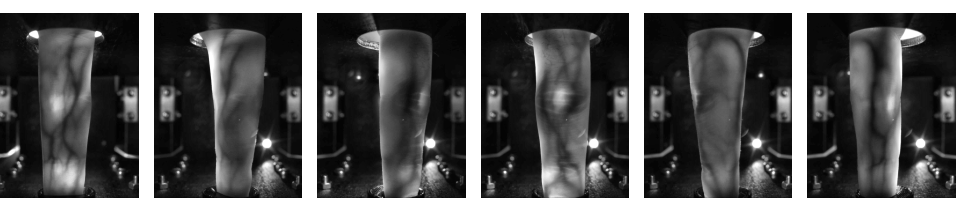
Figure 5. Self-designed multi-perspective finger vein capture device (image originally published in [2]).